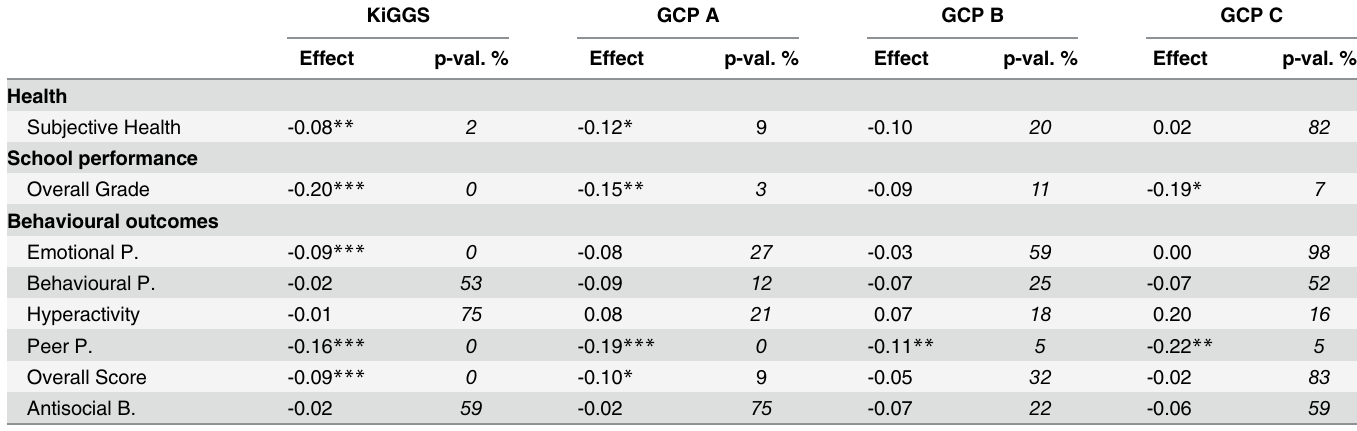
Table 6. Comparison of matching estimates using KiGGS and GCP. Note: The results in the first column (KiGGS) correspond to our main set of results based on the KiGGS data but not controlling for state fixed effects. GPC A to C are based on the GCP data. In GPC A we perform a pure replication of the KiGGS results where we use only the second wave of the GCP for both outcome and control variables. GCP B presents the results when we control addition- ally for the set of lagged outcome variables and replace all control variables by the respective control variables from wave 1. In GPC C we repeat the strategy employed under (B) but restrict the sample to children who do not participate in a sports club in wave 1. The presented effect is the average treatment effect (ATE). p-values are computed by bootstrapping p-values of the t-statistic with 4999 replications